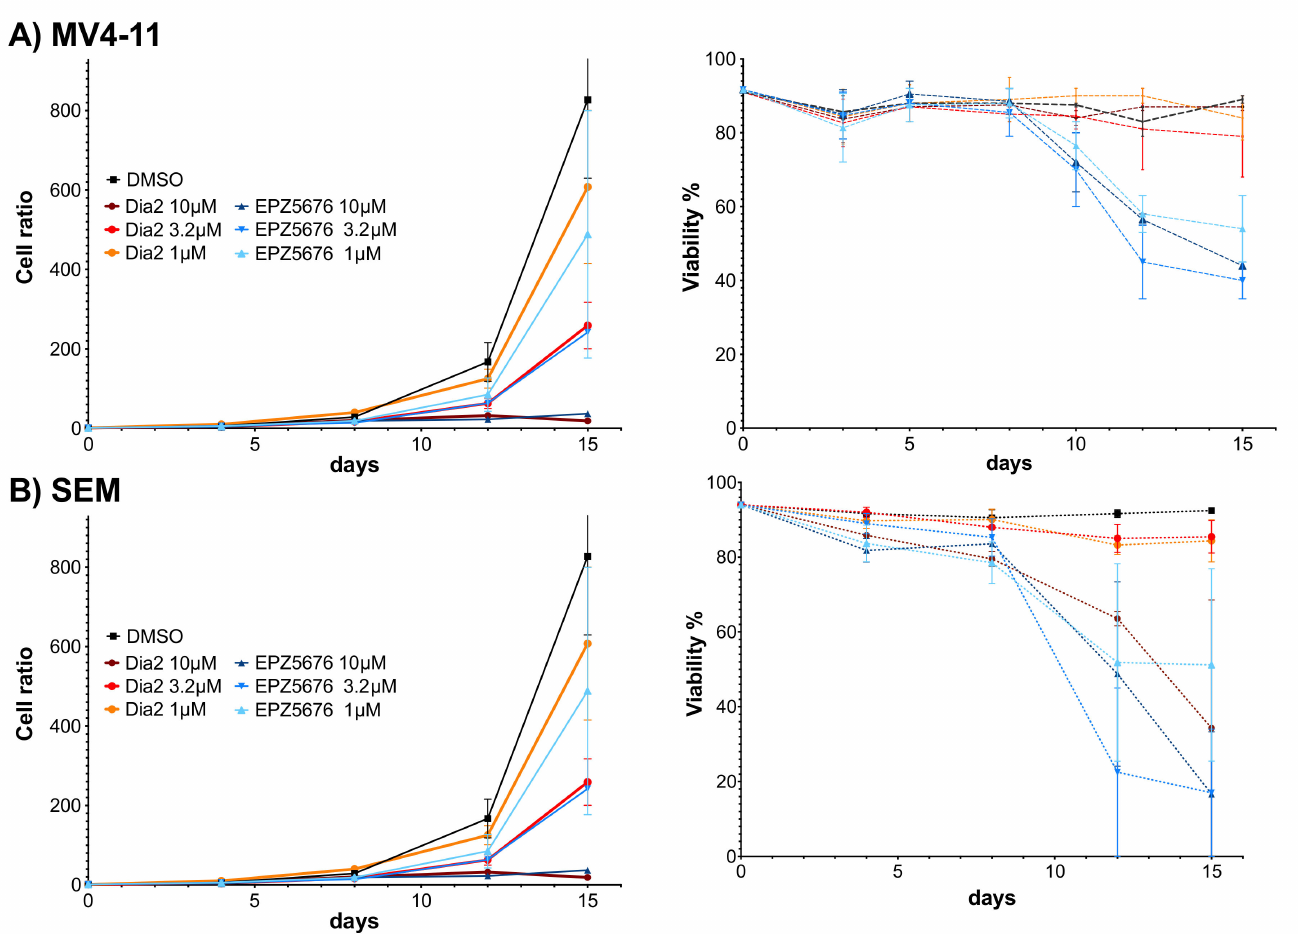
Figure 4. MLL-AF4 cells: MV4-11 ( A ) and SEM ( B ). Right, growth of MLL-AF4 cells up to 15 days of incubation with 10 µ M (bordeaux red circles), 3.2 µ M (red circles), 1 µ M (orange circles) of Dia2 , and 10 µ M (dark blue triangles), 3.2 µ M (blue triangles), 1 µ M (sky blue triangles) of EPZ-5676 compared to DMSO (black squares) were plotted as the ratio of cell amount over initial population. Left, viable cells were counted every 3 to 4 days in the presence of Dia2 , EPZ-5676, or DMSO, the percentage of viability (dotted curves) is reported. Every data point is the result of technical triplicates and biological